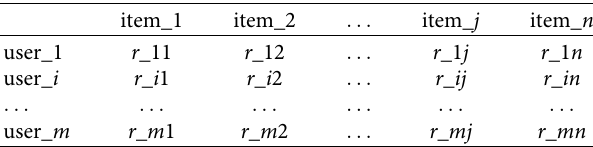
Table 1: User-item rating matrix.